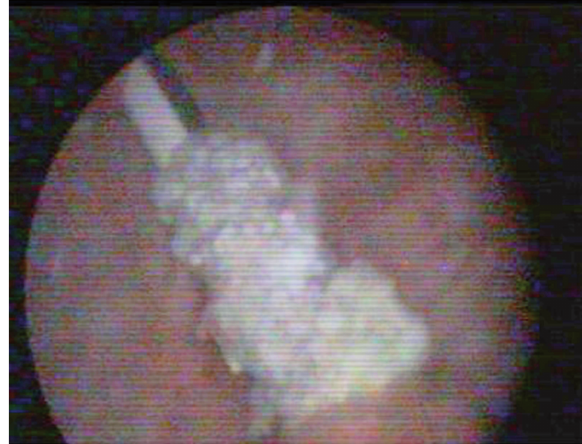
figure 2 - cystoscopy showed encrusted plastic pen inside the bladder extending from right anterior bladder wall up to left posterior bladder